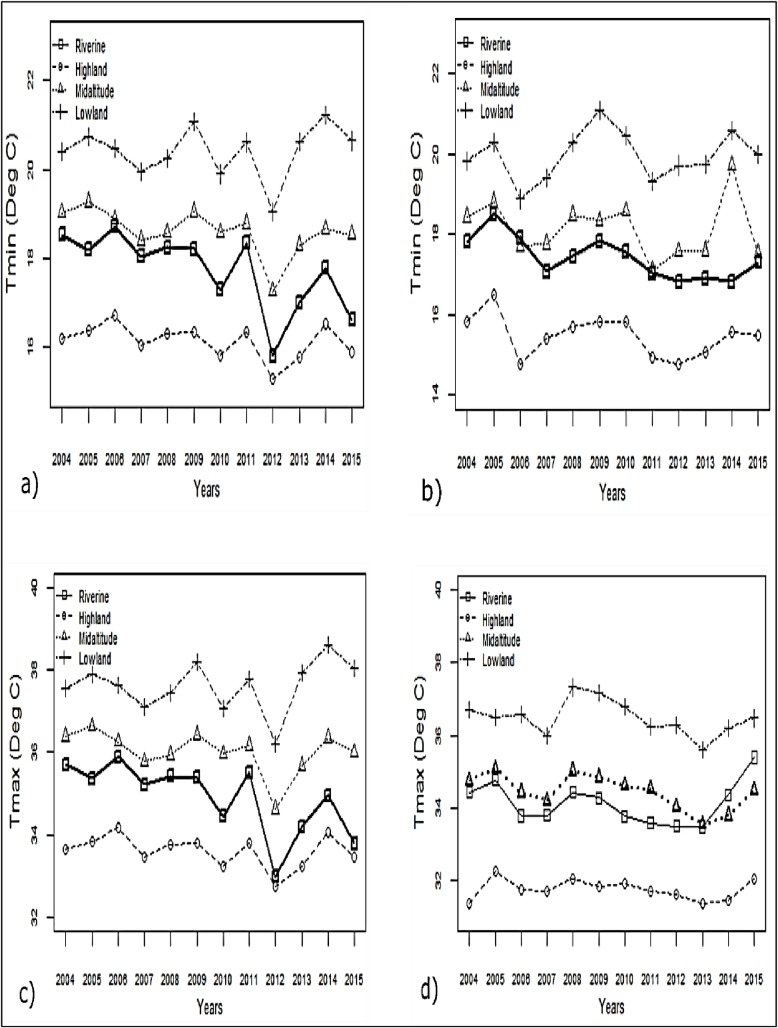
Trends in mean monthly Tmin and Tmax for selected months as examples.(A) January, (B) December, (C) January, and (D) October.